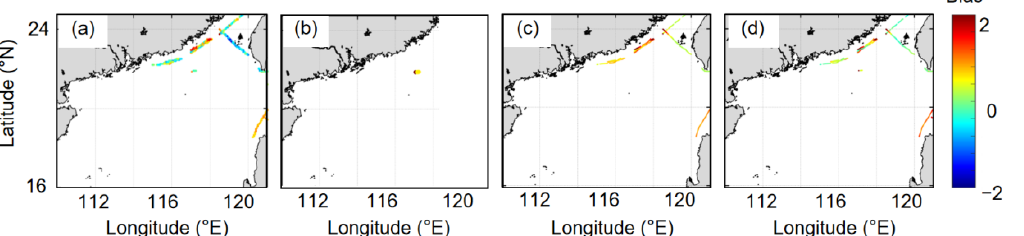
Figure 9. Difference between the model ‐ derived sea surface salinity (SSS) data and concurrent SOCAT underway SSS data. ( a ) Reconstructed data (OR), ( b ) OISSS, ( c ) IAPOS, and ( d ) MUL. The SOCAT data were collected in September 2008, April 2009, and January 2018; the OISSS data were available in January 2018.